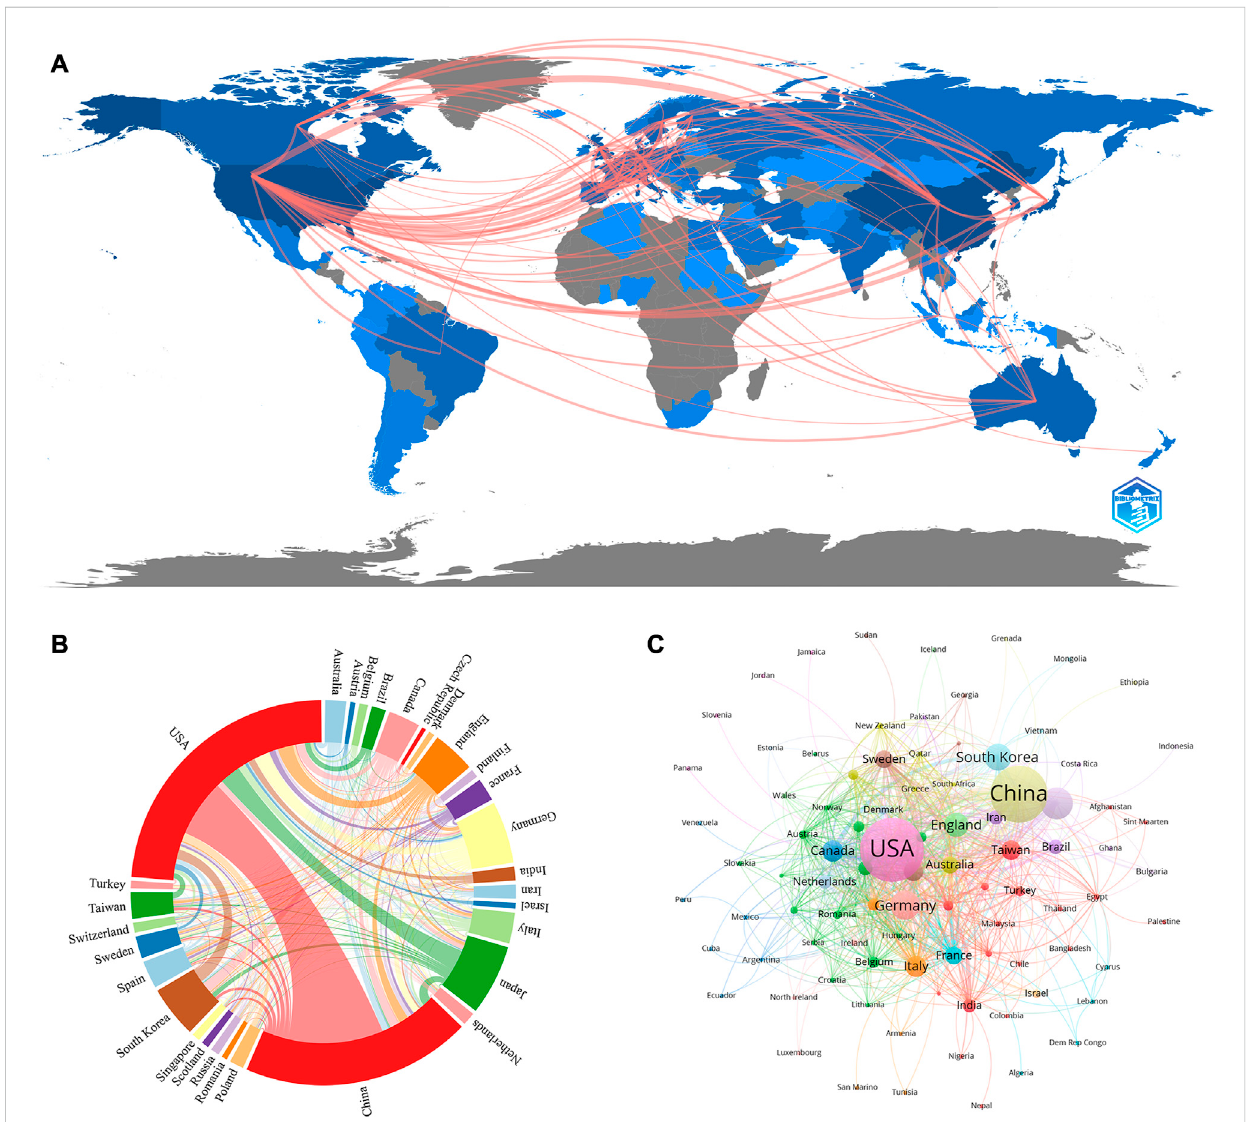
FIGURE 3 (A) Country/region collaboration map. The Darker blues indicated higher collaboration rates, the wider the link line, the higher the rate of collaboration between the two countries. (B) Distribution of countries/regions in the fi eld of stem cells in stroke. The size of the circle represents the number of articles issued by countries or regions, and the line means cooperation among countries or regions (C) Distribution and international cooperation of countries that are involved in stem cells in stroke research. The thickness of the line re fl ects the frequency of the cooperation. The thicker the line, the stronger the